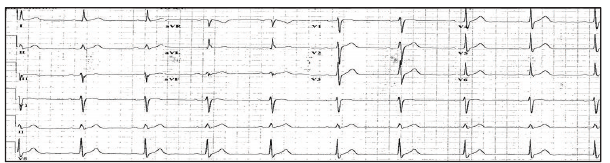
Figure 1: Patient’s baseline 12-lead electrocardiogram. The tracing revealed sinus bradycardia (with heart rate in the 55) with normal axis.